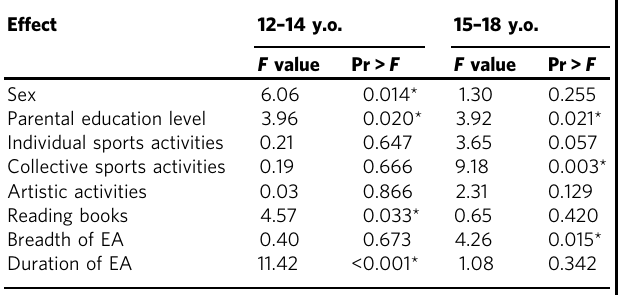
Table 3 Comparison of means for levels of factors evaluated of the multilevel model for each age group with extracurricular activities (EA) as the dependent